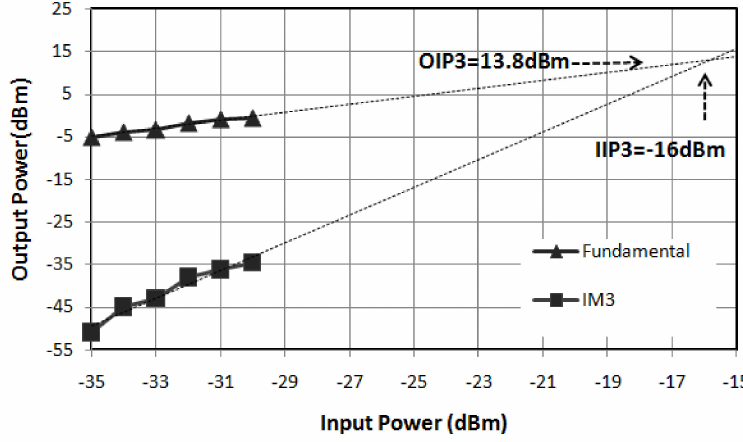
Figure 10. Measured out-of-band IIP3 and OIP3 at the LO frequency of 2.4 GHz.